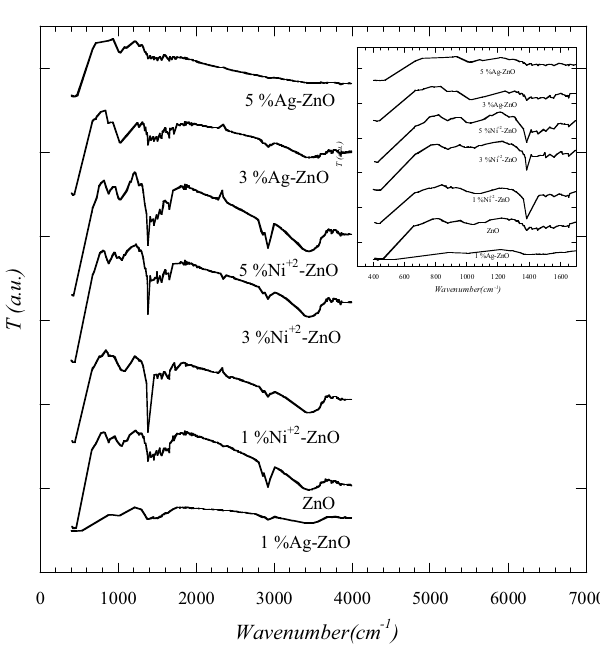
Figure 4. FTIR spectrophotometer of pure, Ni doped ZnO and Ag doped ZnO nanopowders.